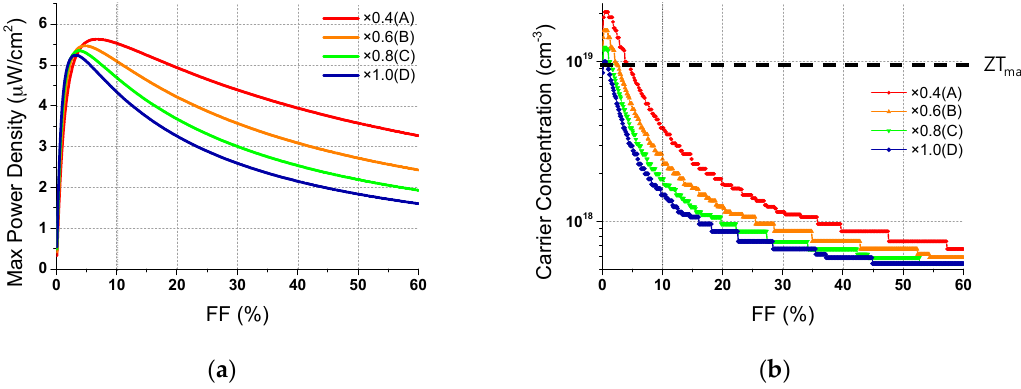
Figure 5. ( a ) Carrier concentration at which the maximum power density is obtained for each material (A, B, C, D) and ( b ) power density at that time according to FF change.